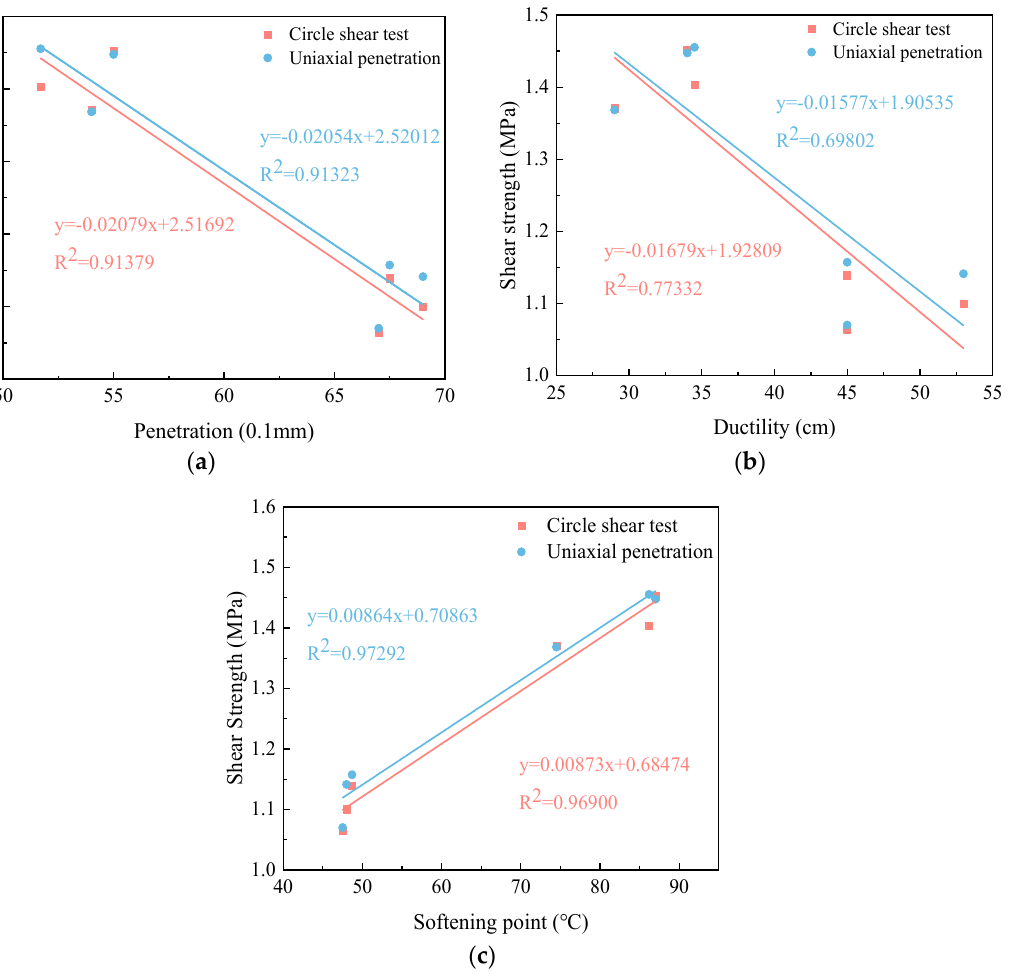
Figure 7. Relationships between shear strength of tests and three indexes. ( a ) Penetration; ( b ) Ductility; ( c ) Softening point.